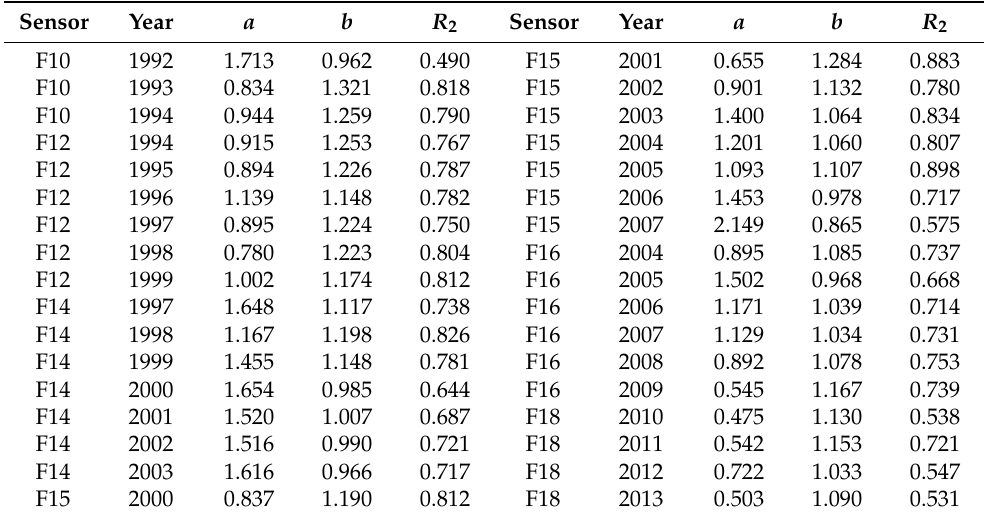
Table 1. Parameter values and estimated correlation coefficient for DMSP image regression correction